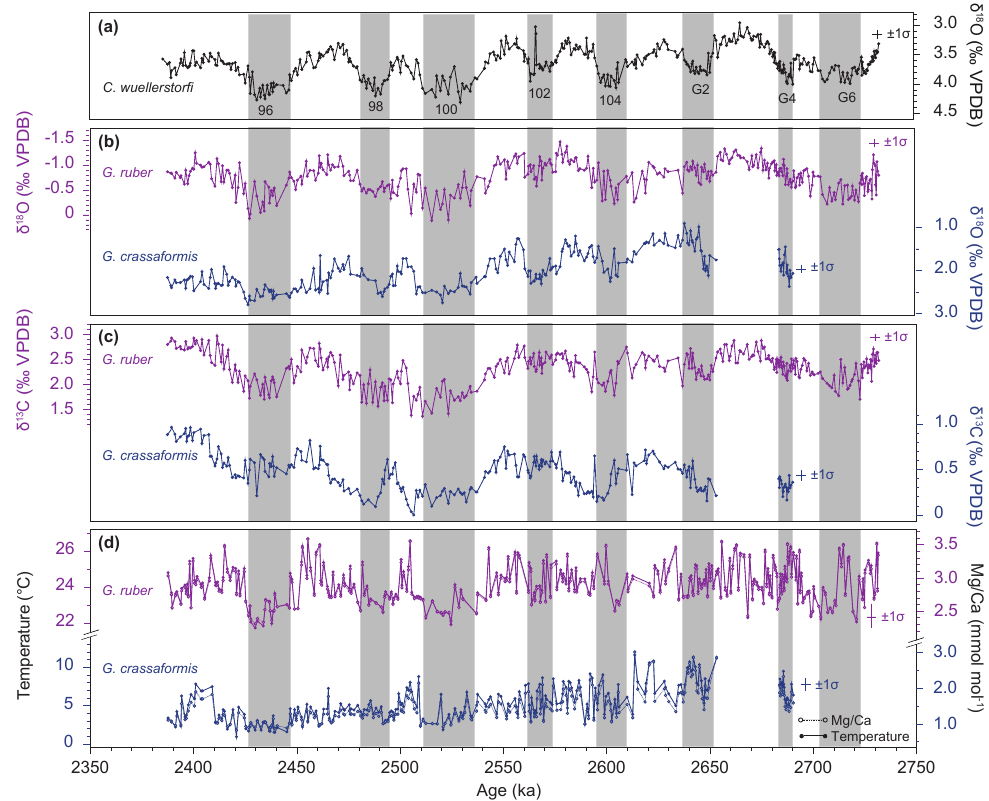
Figure 5. Planktic foraminiferal proxy records from ODP Site 849 for MIS G7–95 ( ∼ 2 . 75–2.4Ma). (a) Benthic foraminiferal ( C. wueller- storfi ) δ 18 O stratigraphy (Jakob et al., 2017). (b) δ 18 O data of G. ruber (purple; Jakob et al., 2017) and G. crassaformis (blue; this study). (c) δ 13 C data of G. ruber (purple; Jakob et al., 2016, this study) and G. crassaformis (blue; Jakob et al., 2016, this study). (d) Mg / Ca (dashed line, open dots) and temperature (solid line, filled dotes) data of G. ruber (purple; Jakob et al., 2017) and G. crassaformis (blue; this study). Gaps in the G. crassaformis dataset for 2.68–2.65Ma (MIS G3) and 2.73–2.69Ma (MIS G7–G5) are due to the lack of G. crassaformis specimens in the investigated size fraction (315–400µm). Horizontal and vertical bars indicate the 1 σ standard deviation associated with the age model and the individual proxy records, respectively. Grey bars highlight glacial